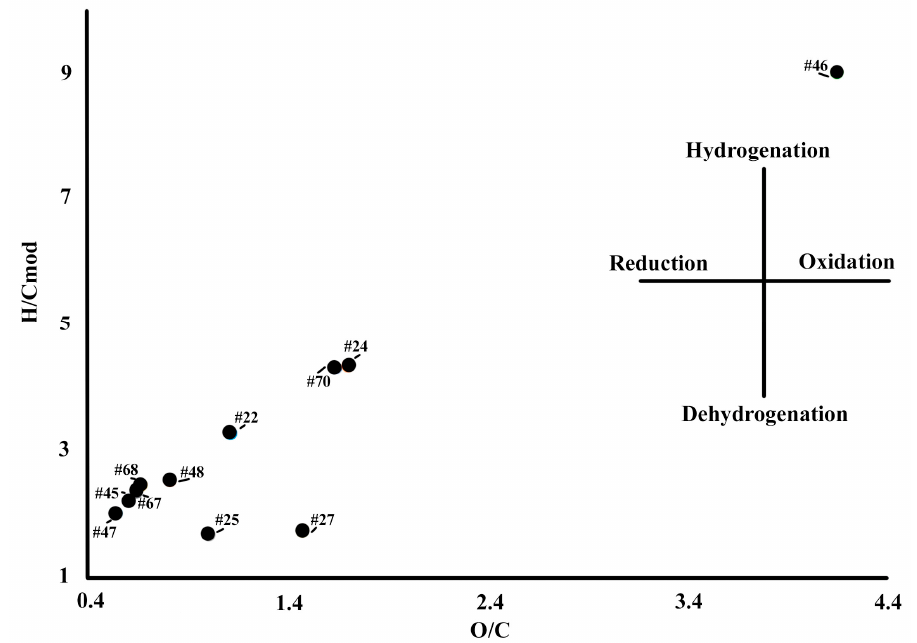
Figure 3. Elemental composition of the studied HAs. Soil ID correspond to Table 2. Hydrogena- tion/Dehydrogenation and Reduction/Oxidation are the processes going in the HAs molecules.